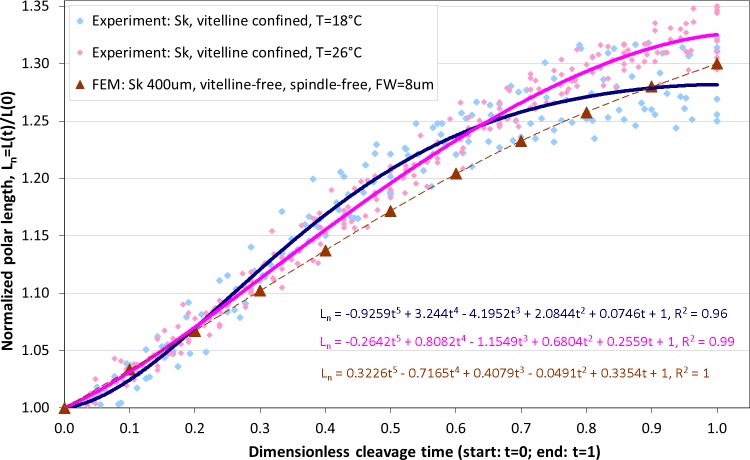
Comparison of polar elongation measurements of Sk cells between two different temperatures (18 °C and 26 °C) vs. FE simulation of egg cleavage resulting from contraction of equatorial furrow.Dots represent cumulative measurements of relative elongation of embryonic Sk cells under the given temperature condition as a function of dimensionless cleavage time Ln(t). Each dot corresponds to simulated re. measured polar cell length Ln(t) at a distinctive time point (t = [0, 1]) of the cleavage. Lines depict polynomial data fits.